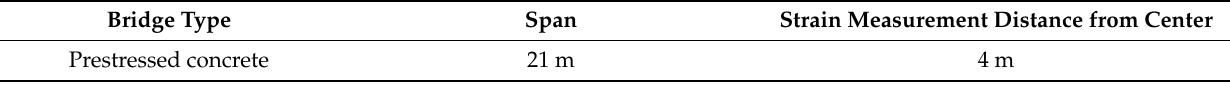
Figure 7. Experimental setup: ( a ) overview and ( b ) sensor deployment.